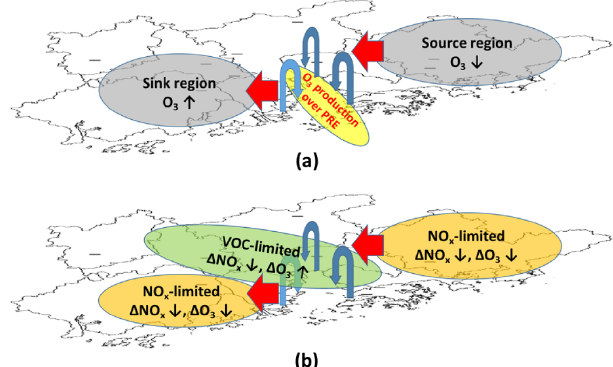
Figure 12. A conceptual diagram of the impact of local emissions on (a) ozone concentrations and (b) their changing trends in the Pearl River Delta during ozone pollution episodes. The blue curved arrows indicate microscale circulations, such as a land–sea breeze, that have developed around the Pearl River Estuary (PRE). The mi- croscale circulations lead to a high ozone area around the PRE due to effective mixing and reaction between VOCs and NO x . High ozone is transported to the southwestern PRD by easterly winds, increasing the local ozone contribution. In comparison, the north- eastern PRD is a source region for ozone; therefore, the local con- tribution from this region is negative. With higher biogenic VOC emissions and a higher VOC oxidation rate during ozone episodes, most of the PRD is in the NO x -limited OFR except for urban cen- tral PRD which is still VOC-limited due to intense NO x emissions. Therefore, reduced NO x emissions ( (cid:49) NO x ↓ ) lead to a decreasing ozone level ( (cid:49) O 3 ↓ ) over both the northeastern and southwestern PRD and an increasing ozone level over central PRD ( (cid:49) O 3 ↑